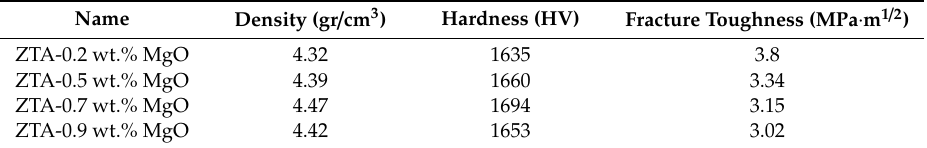
Figure 5. Effects of MgO addition in Zirconia toughened alumina (ZTA) on fracture toughness and Figure 5. E ff ects of MgO addition in Zirconia toughened alumina (ZTA) on fracture toughness hardness. and hardness. Table 1. Properties of ZTA with di ff erent amount Table 1. Properties of ZTA with different amount MgO.